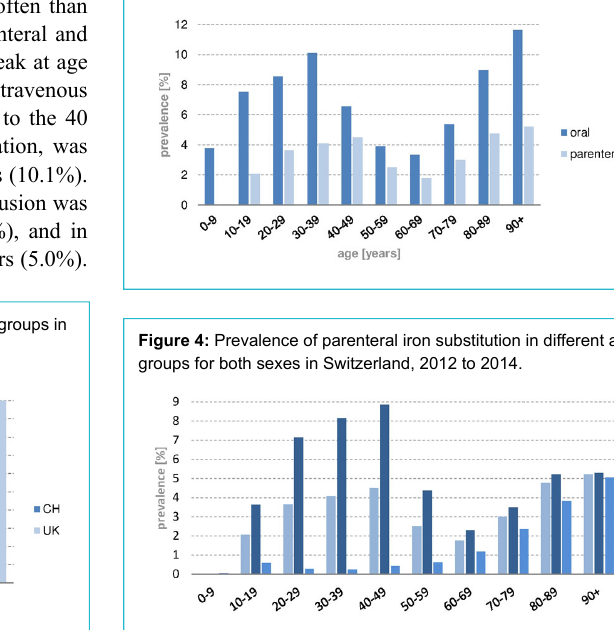
Figure 3: Prevalence of oral and parenteral iron substitution in dif- ferent age groups in Switzerland, 2012 to 2014.